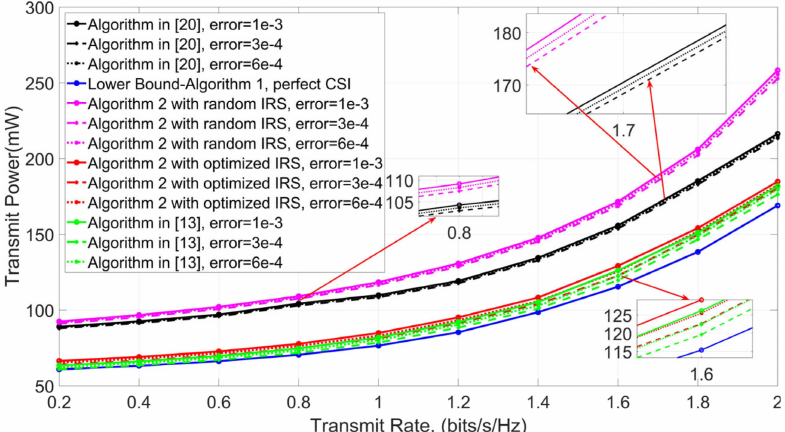
Figure 3. Effectiveness of the proposed algorithm under different numbers of the transmit rate.